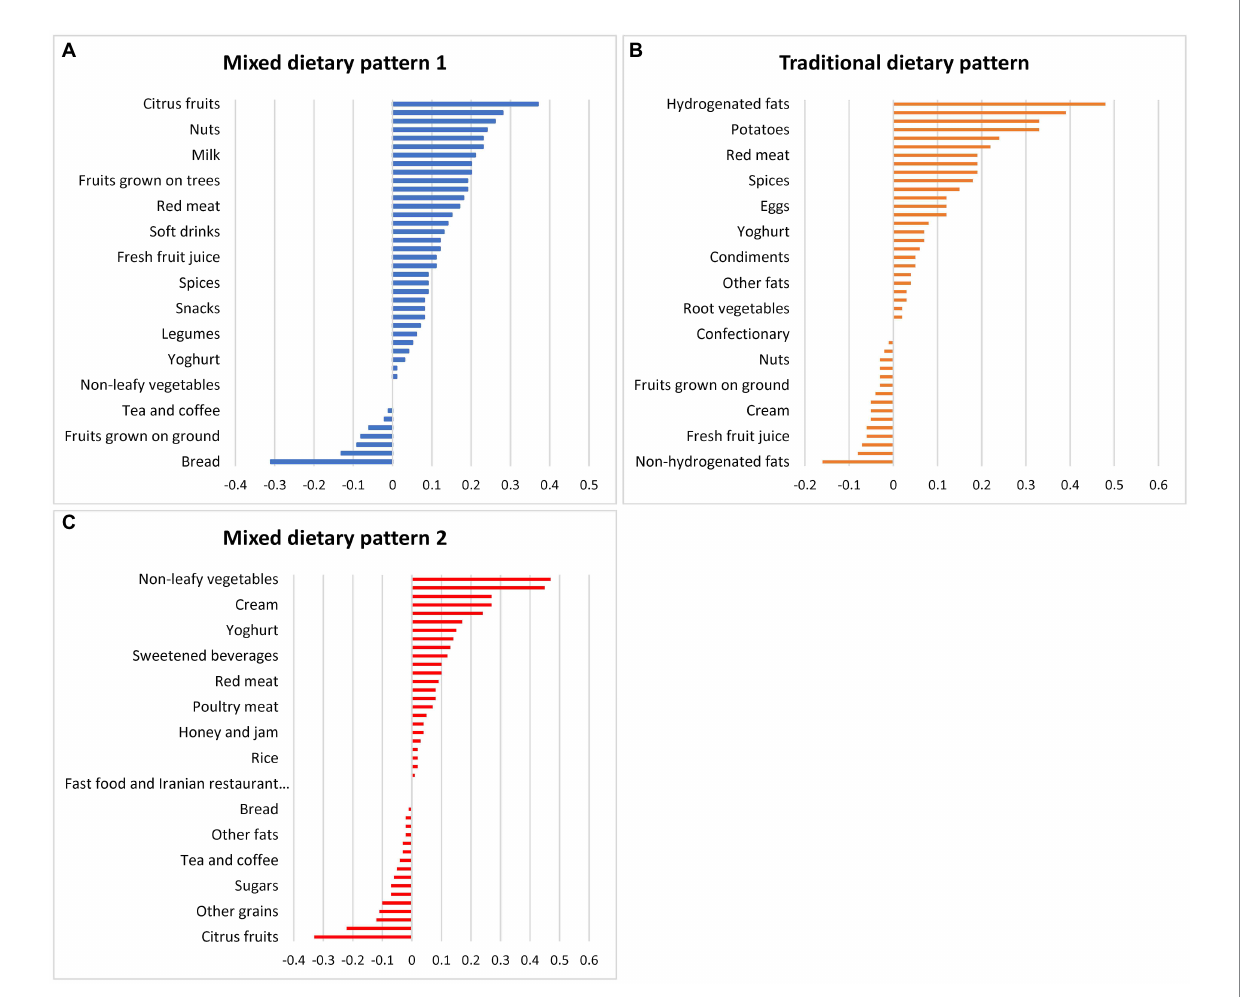
FIGURE 2 Factor loadings for the (A) mixed dietary pattern 1, (B) traditional dietary pattern, and (C) mixed dietary pattern 2 in Iranian household identified by principal component